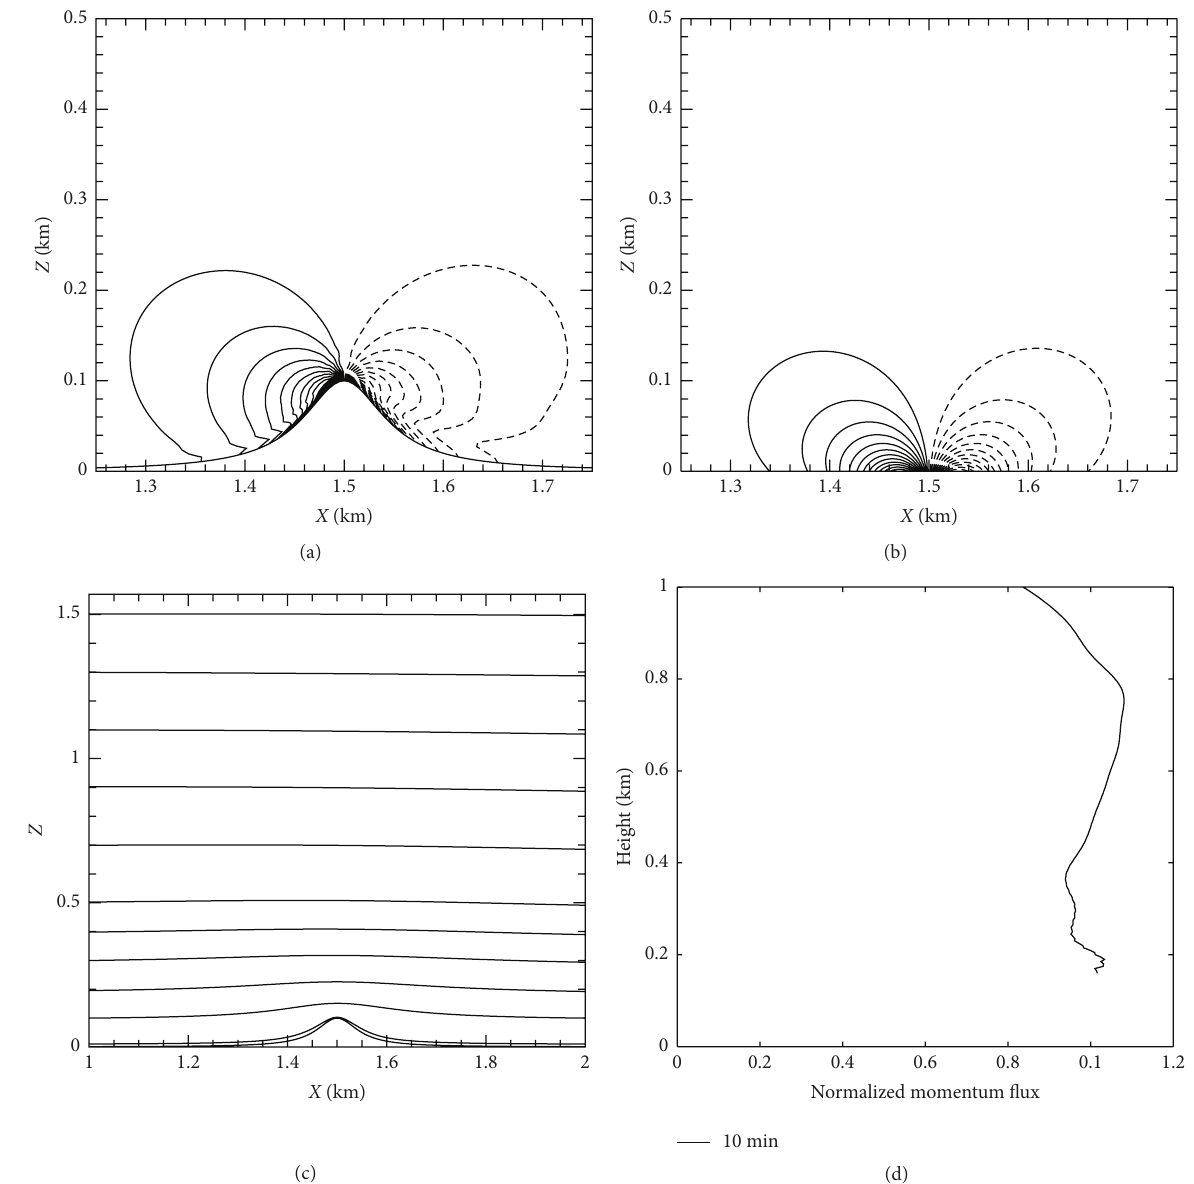
Figure 4: Same as Figure 3, but for case A4. Contour interval is 1.0ms −1